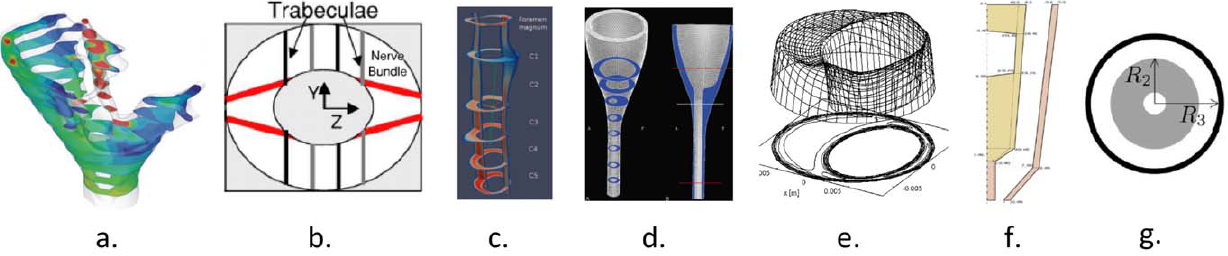
Figure 1. Varying levels of anatomical assumptions in the literature when simulating CSF in the cervical spine. (Decreasing level of anatomical complexity from left to right, respectively). a) A subject-specific rigid wall geometry with CSF moving within a SSS of anisotropic porosity [15]. b) An idealized 2D SSS geometry including spinal cord nerve roots, arachnoid trabeculae and denticulate ligaments in a symmetric arrangement around the spinal cord [20]. c) A subject-specific 3D SSS geometry without small anatomical structures and geometric smoothing [23]. d) An idealized 3D geometry of a healthy subject [22]. e) The first simulation of CSF in the cervical SSS idealized as two concentric ellipses [14]. f) A 2D axisymmetric spinal cord and dura model with moving walls [30]. g) A 2D axisymmetric model of wave propagation in the spine based on an analytical solution of concentric elastic tubes [28]. Refer to Table 1 for details in each simulation.